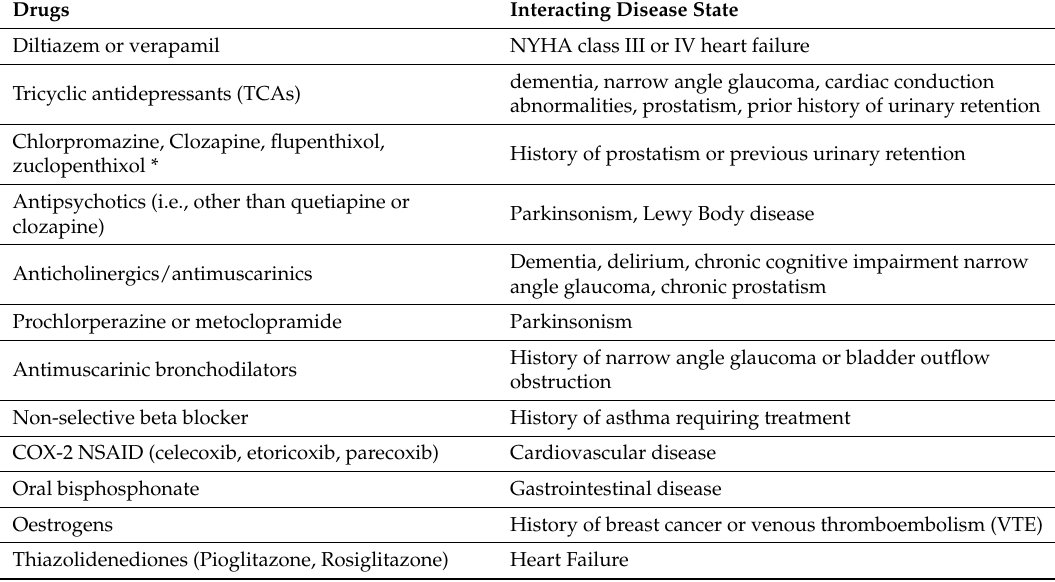
Table 3. PIMs related to drug-disease interactions under selected STOPP version 2